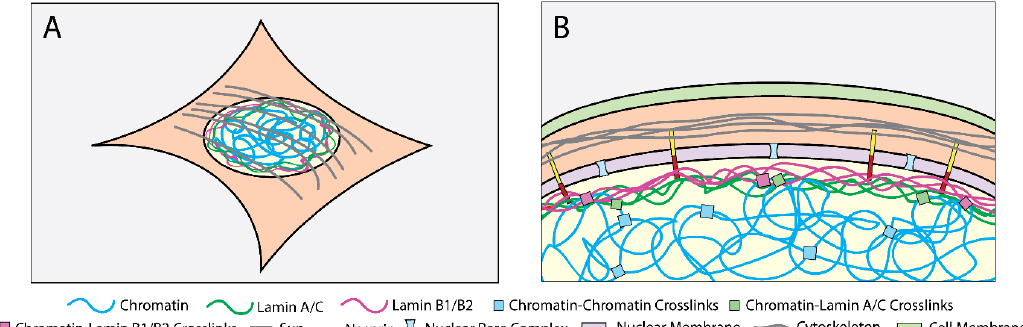
Figure 2. ( A ) A schematic of a whole cell. ( B ) A close-up, cross-section schematic of the ventral half of the cell drawn in ( A ). The proteins, structures, and interactions are a subset of the full system, but are historically those which are relevant to consider when developing a mechanical model for nuclei.